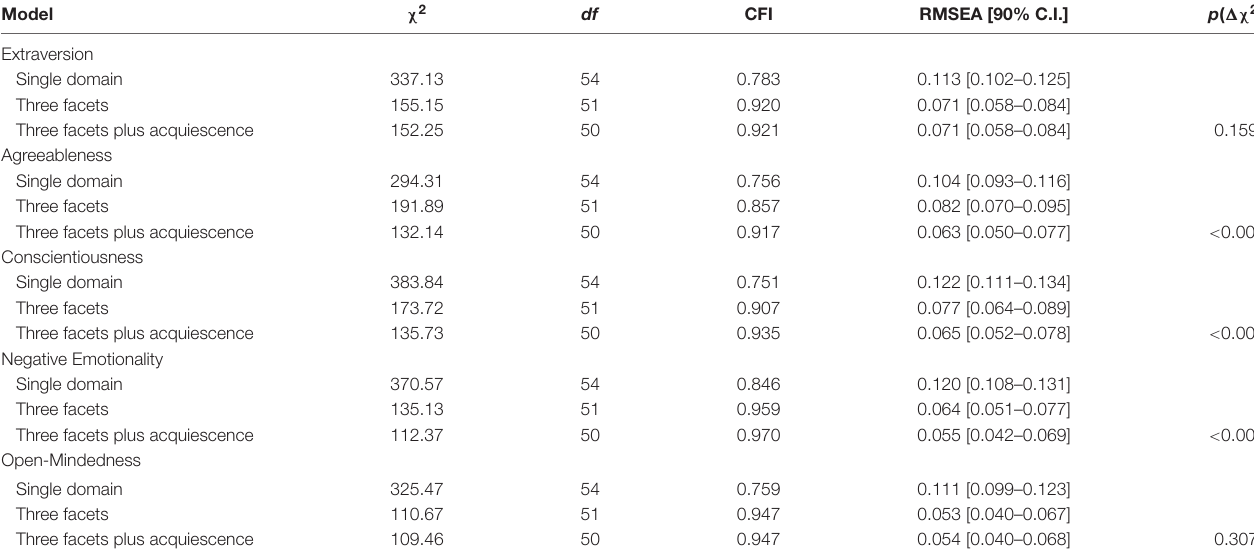
TABLE 7 | Fit indices for CFA models of item scores from the BFI-2 domains. Model χ 2 df CFI RMSEA [90% C.I.]